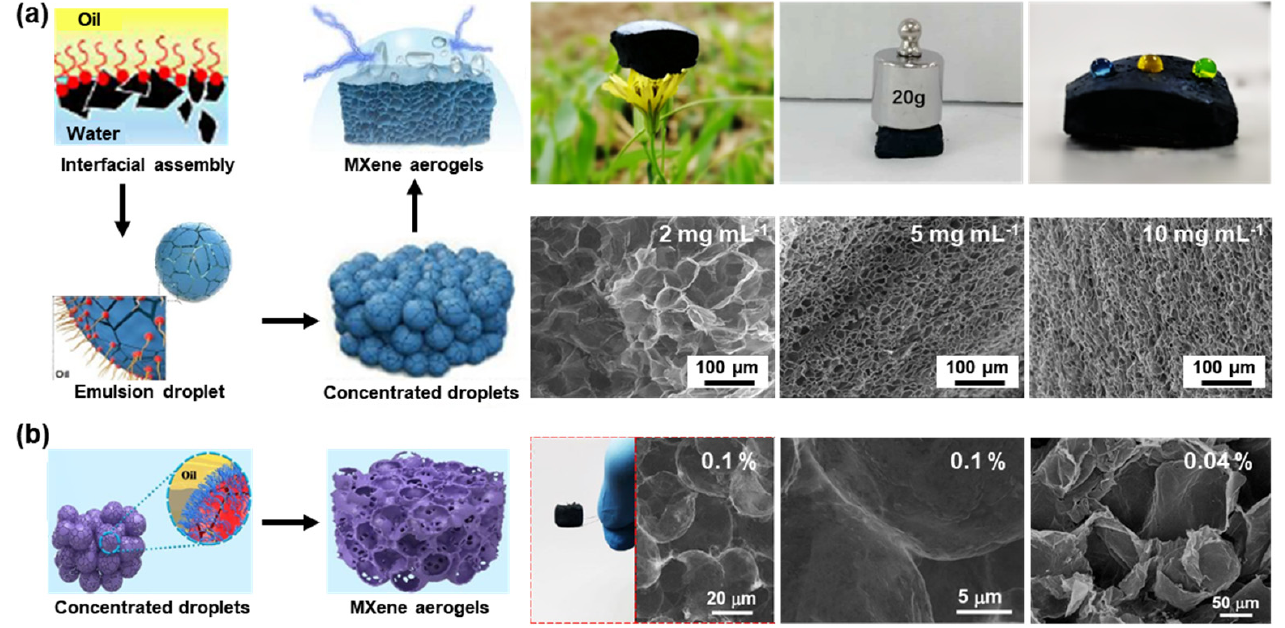
Figure 5. ( a ) Schematic illustration of collaborative assembly of MXSs at toluene–water interface and the MXS aerogel; optical photographs showing the lightweight, robust, and hydrophobic MXS aerogel; and SEM images MXS aerogels prepared from emulsion templates with different MXene concentrations. ( b ) Schematic illustration of JMN aerogel; optical photograph showing the lightweight property; and SEM images of JMN aerogels prepared from emulsion templates with different JMN contents. ( a ) is reproduced with permission from ref. [93]. Copyright 2019, Wiley-VCH. ( b ) is reproduced with permission from ref. [96]. Copyright 2022, Elsevier.